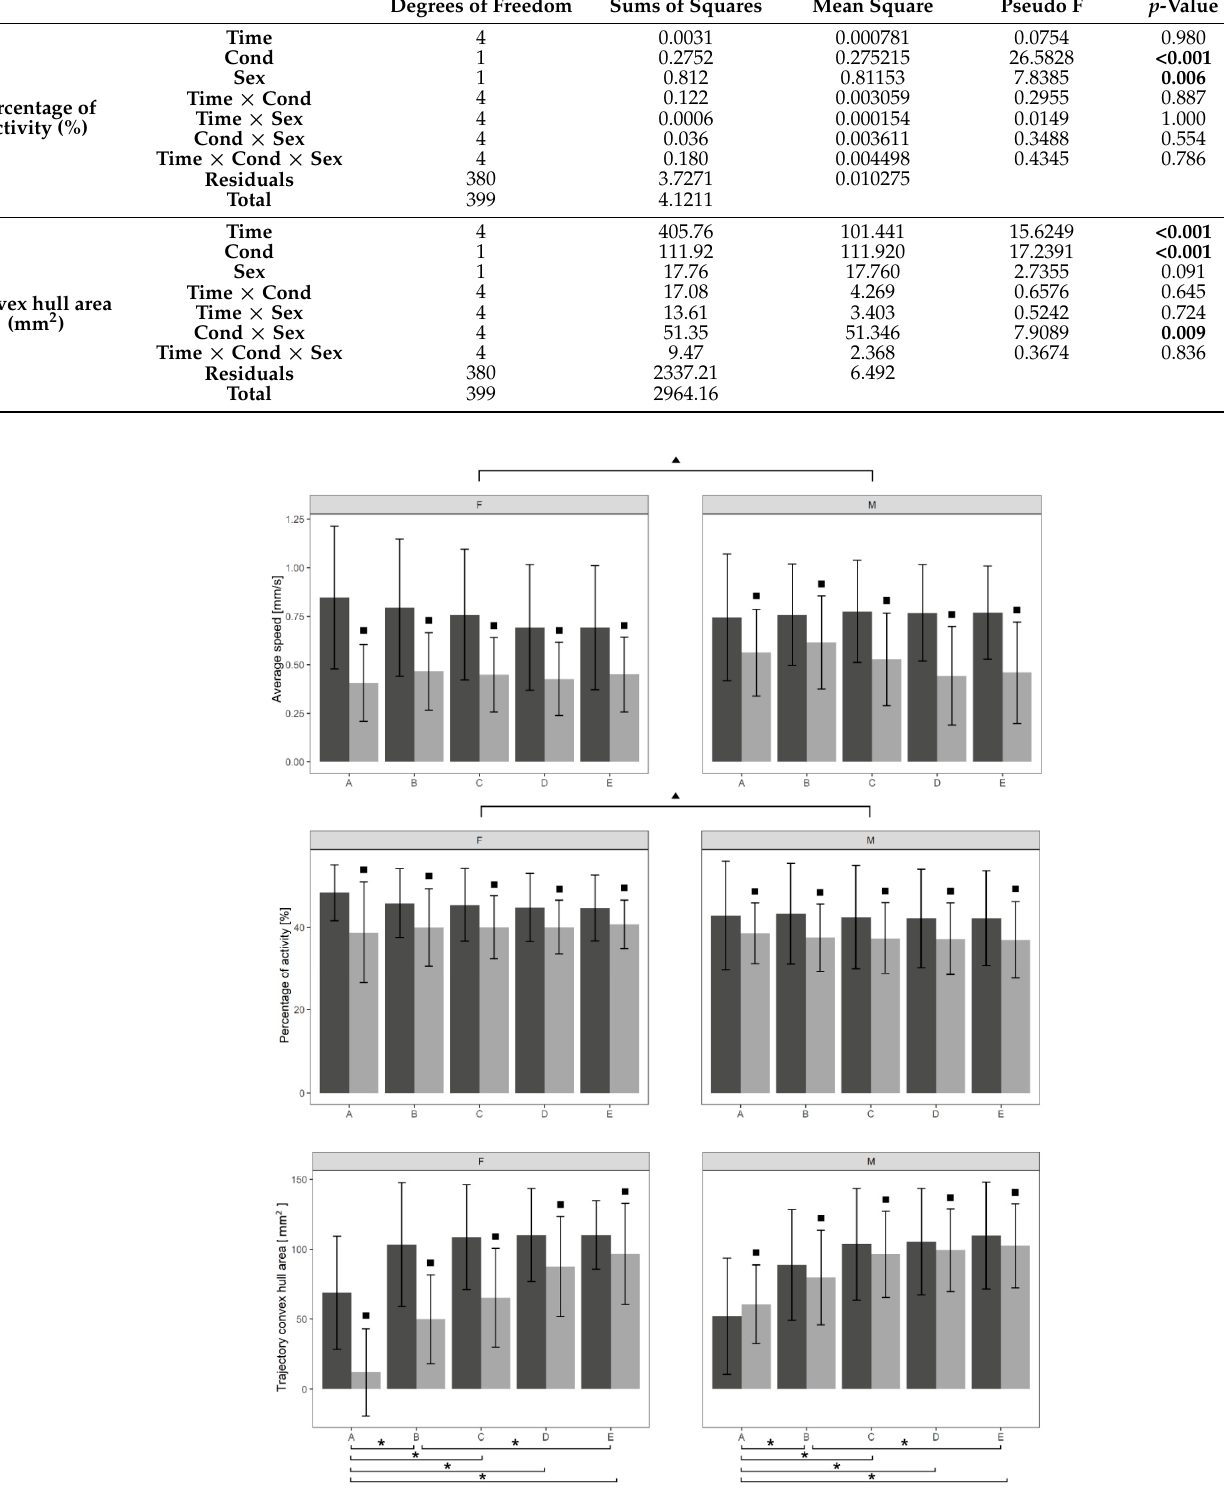
Figure 2. Bar plots of the studied trajectory parameters (mean ± SD; n = 20). M: males; F: females. Dark grey: controls; light grey: treatments. A = one minute of recording; B = two minutes of recording; C = three minutes of recording; D = four minutes of recording; E = five minutes of recording. * = significant differences for Factor 1 (Time); ⯀ = significant differences for Factor 2 (Condition); ▲ = significant differences for Factor 3 (Sex).